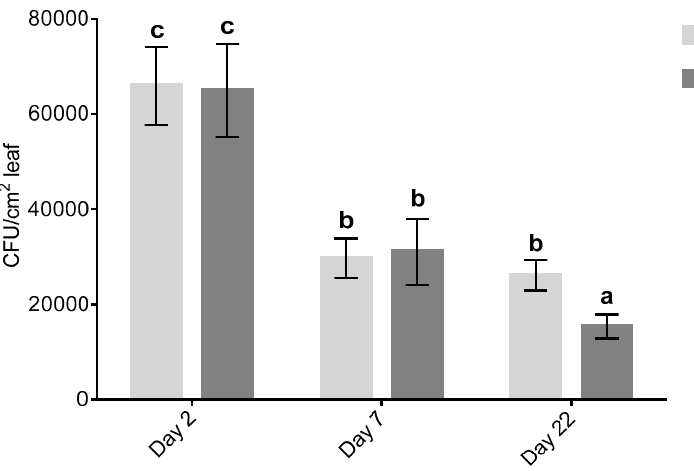
Figure 3. Average populations of Aureobasidium pullulans CG163 (CG163) (CFU / cm 2 leaf) on upper immature still expanding and lower fully expanded Actinidia chinensis var. deliciosa ‘Hayward’ leaves. Five leaf discs per plant were taken 2, 7 and 22 days after CG163 spray treatment. Values are means ± standard errors of nine biological replicates. Each biological replicate consisted of an average of five leaf discs per leaf. Different letters are based on back-transformed average CG163 populations and are significantly different according to Fisher’s Least Significant Difference test (LSD) at the 5% level. Plants 2019 , 8 , x FOR PEER REVIEW